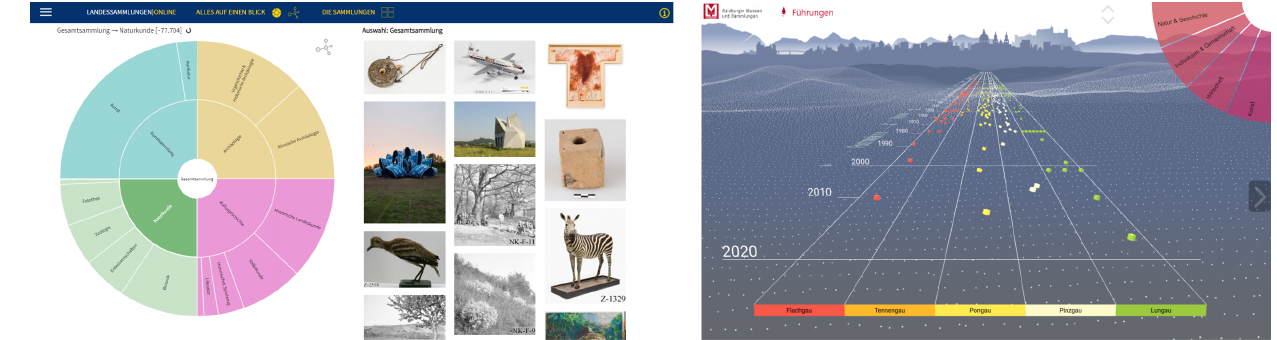
Figure 3. Collection visualizations based on a hierarchical classification of objects ( left ) and their geo-temporal origin ( right